Question: In a single sentence, describe what this figure presents.
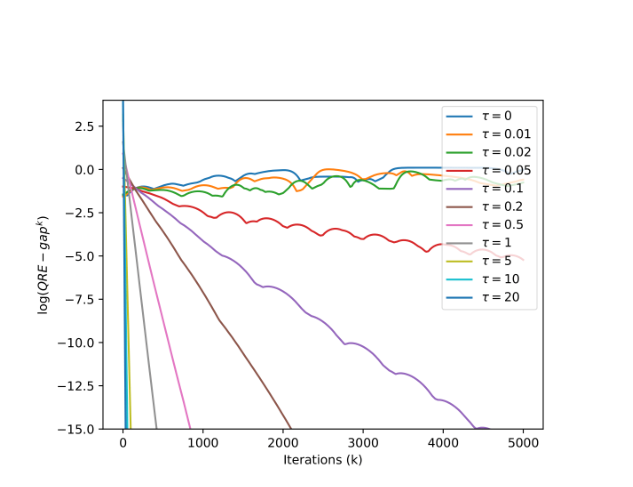
Answer: Convergence of QRE-gap in random game with different τ.